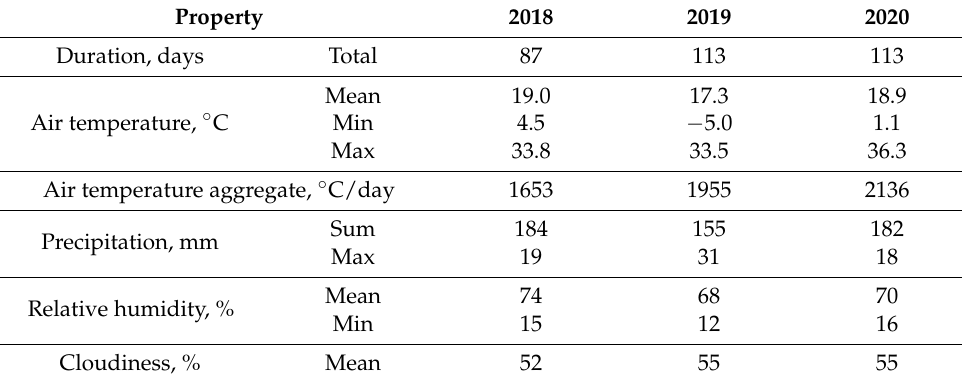
Table 1. Some characteristics of the potato-growing periods in the microplot field experiment in the south of West